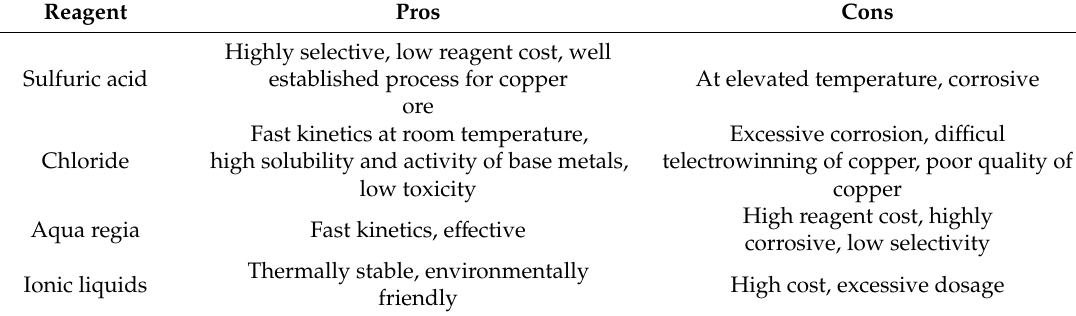
Table 3. Comparison of potential leaching reagents for base metal extraction from waste printed circuit boards [2,20–23].